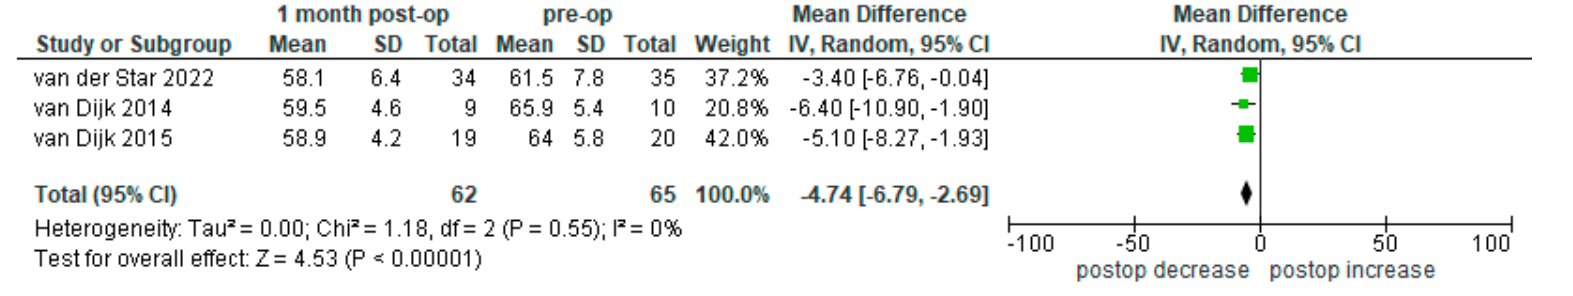
12 of 28 Figure A4. Di ff erence in pachymetry central point across 3 studies [28,31,43].